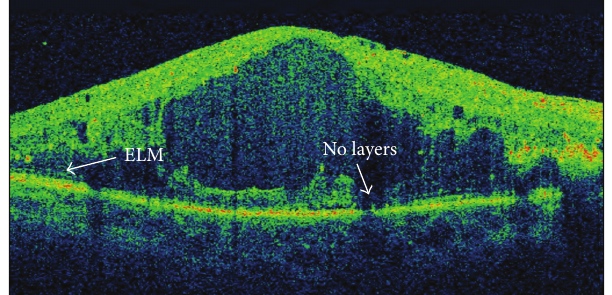
Figure 4: Absence of ellipsoid (ellipsoid zone) layer and external limiting membrane (ELM).